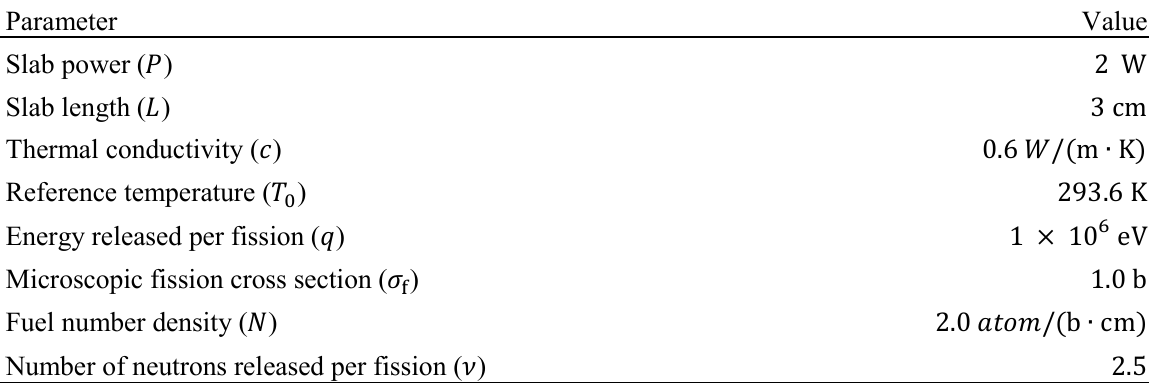
Table 1: Parameters for Eigenvalue Doppler Slab